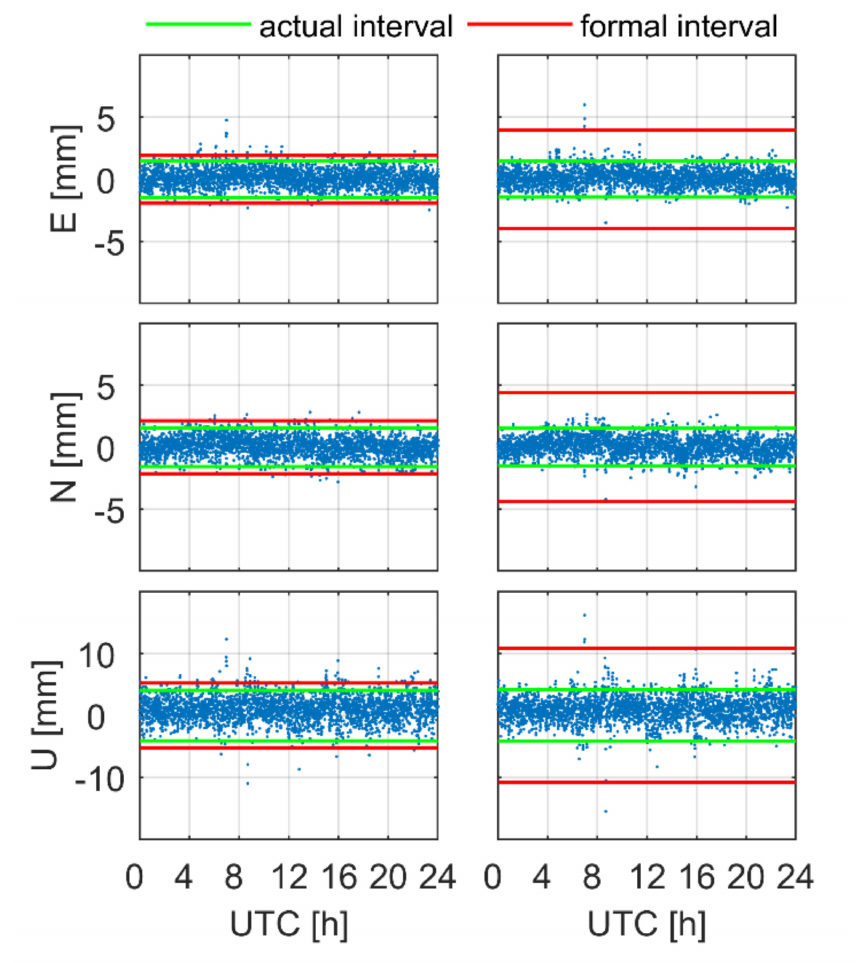
Figure 8. GPS+BDS+Galileo dual-frequency ionosphere-fixed RTK positioning errors with a realistic (left) and an empirical (right) stochastic model. The green and red lines represent the actual and formal 95% confidence intervals, respectively. The data were collected from baseline IGG1–IGG2 on DOY 269,